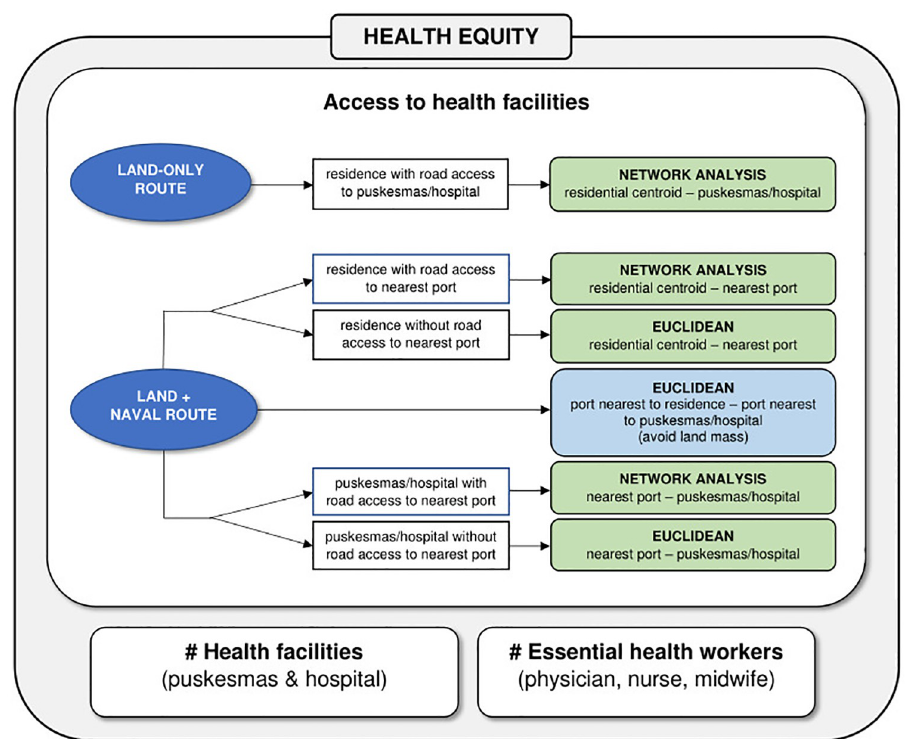
Fig 1. Diagram illustrating the three components of health equity considered in the present study, including the processing steps for calculating spatial accessibility to health facilities. Green boxes denote land route, blue box denotes naval